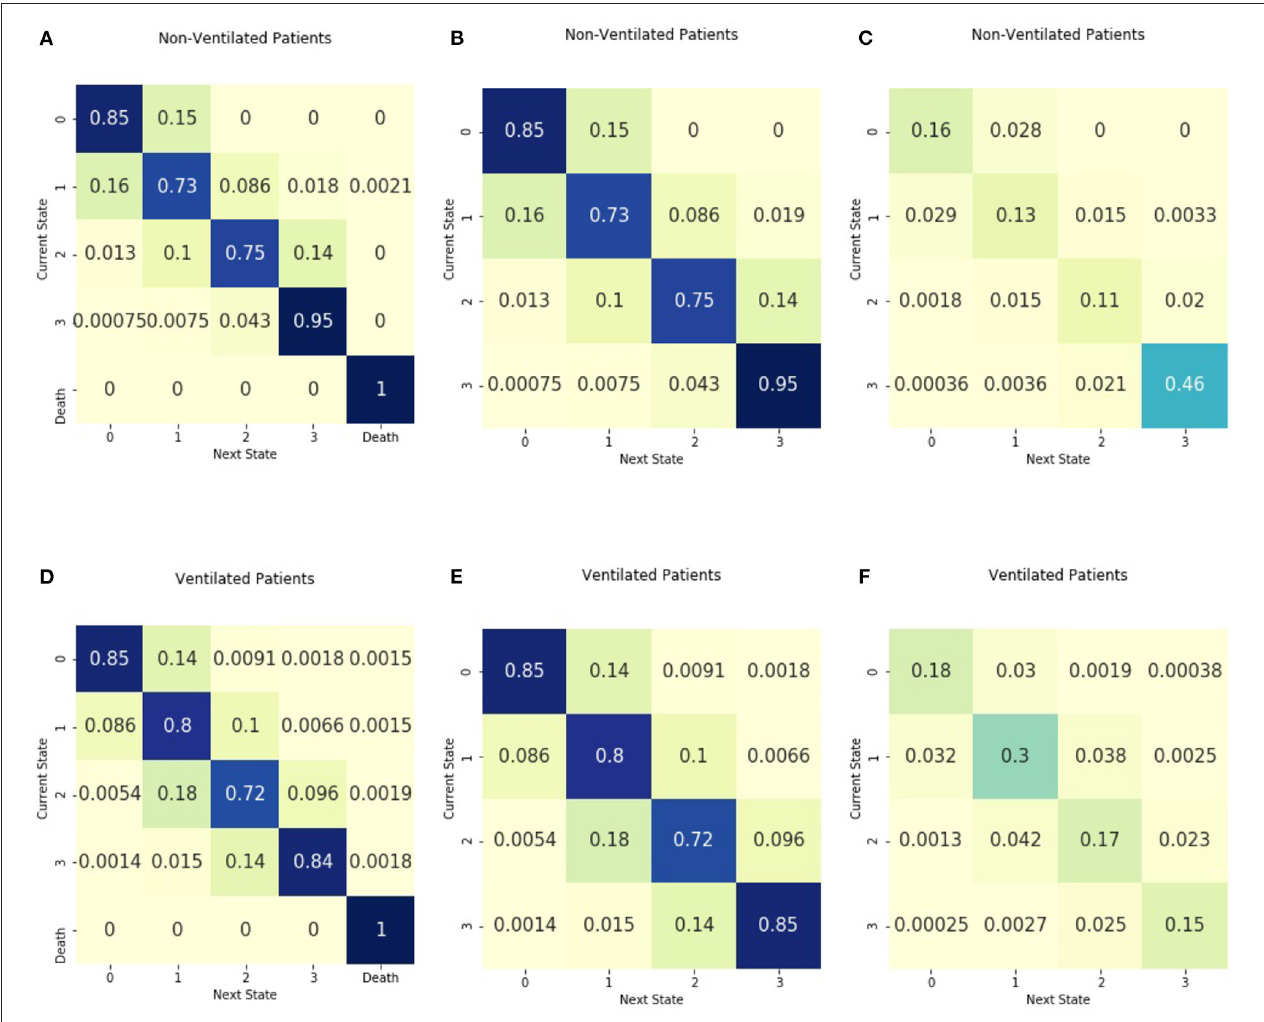
FIGURE 4 | Transition matrices stratified by ventilator use. Separate transition matrices were created for (A) patients without mechanical ventilation and including death as an absorbing state (B) patients without mechanical ventilation with only transient illness states, and (C) the entropy matrix for patients without mechanical ventilation. The transition matrices are shown for (D) patients requiring mechanical ventilation, including death as an absorbing state (E) patients requiring mechanical ventilation with only transient illness states, and (F) the entropy matrix for patients requiring mechanical